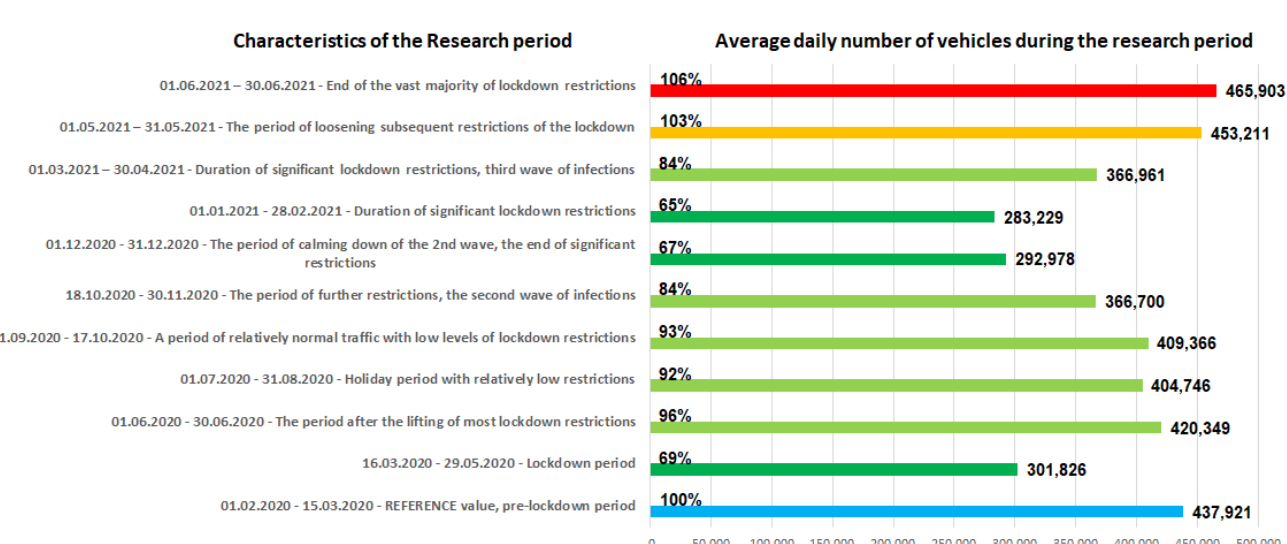
(i.e., commuting to work and places of study) is evidenced by changes in the number